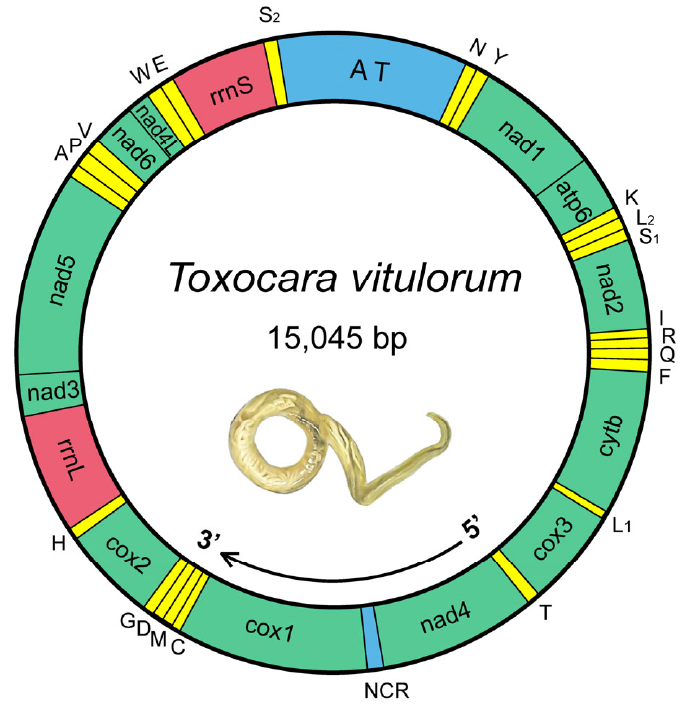
Figure 1. Circular map for T. vitulorum mitogenome. 36 genes follow standard nomenclature, including 22 tRNAs, which are denoted by one letter in accordance with the IPUC-IUB single-letter amino acid codes. The two leucine genes were differed by L1 and L2, and the two serine genes by S1 and S2. All the genes are present on the same strand and transcribed in the same direction (5 ′ – 3 ′ ), as indicated by the arrow. NCR indicates the non ‐ coding region. AT indicates the AT ‐ rich region. Table 2. The structure and organization of the mitogenome of T. vitulorum. Start Stop Intergenic Gene Location Length Anticodon Codon Codon Region trnN 1–59 59 GUU 0 trnY